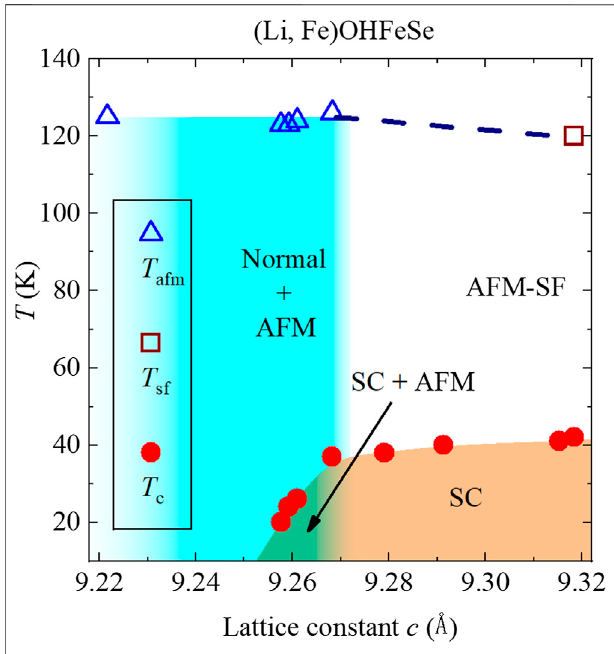
FIGURE4 | Electronic phase diagram of(Li,Fe)OHFeSe system [60,